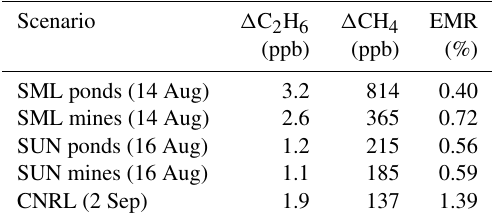
Table 1. Enhancements of (cid:49) C 2 H 6 from canister measurements overlapping the CH 4 plumes across three flights (14 August, 16 Au- gust and 2 September). Mean enhanced (cid:49) CH 4 is shown over the course of ∼ 20s canister sampling times with ethane-to-methane ratios (EMRs)